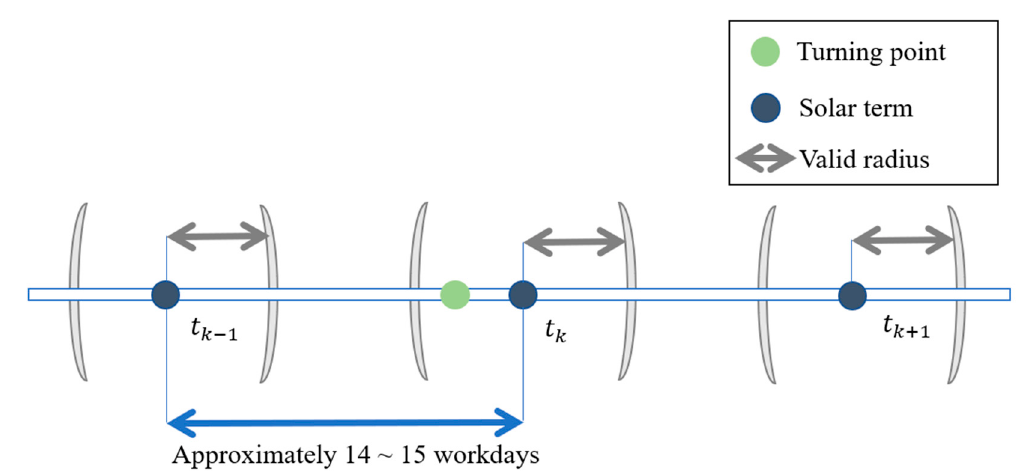
Figure 4. Valid time radius.